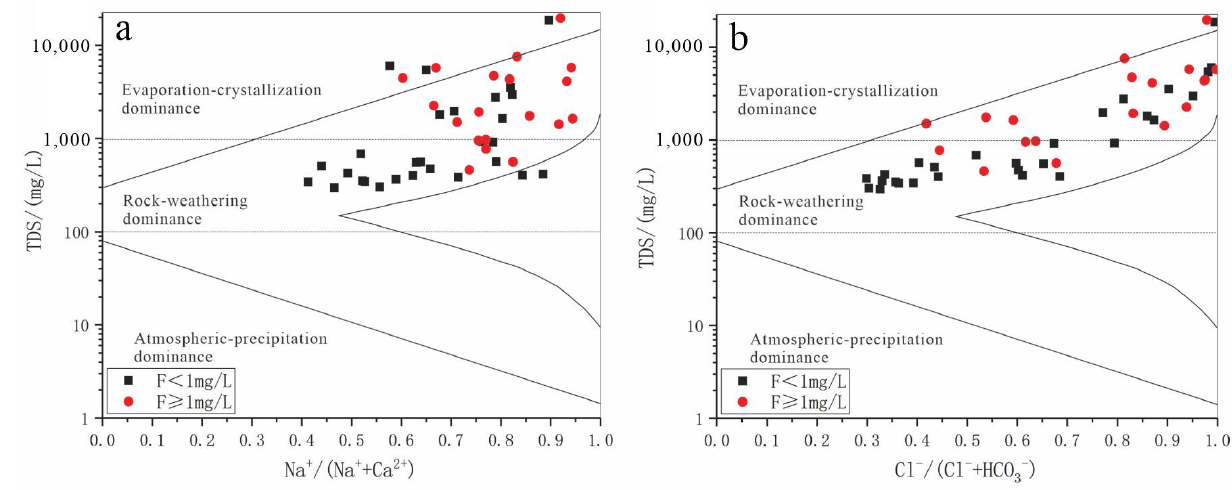
Figure 10. Variation of the weight Na + /(Na + + Ca 2+ ) ratio ( a ) and Cl − /(Cl − + HCO 3 − ) ratio ( b ) as a function of TDS value of groundwater samples in modified Gibbs scheme diagrams.